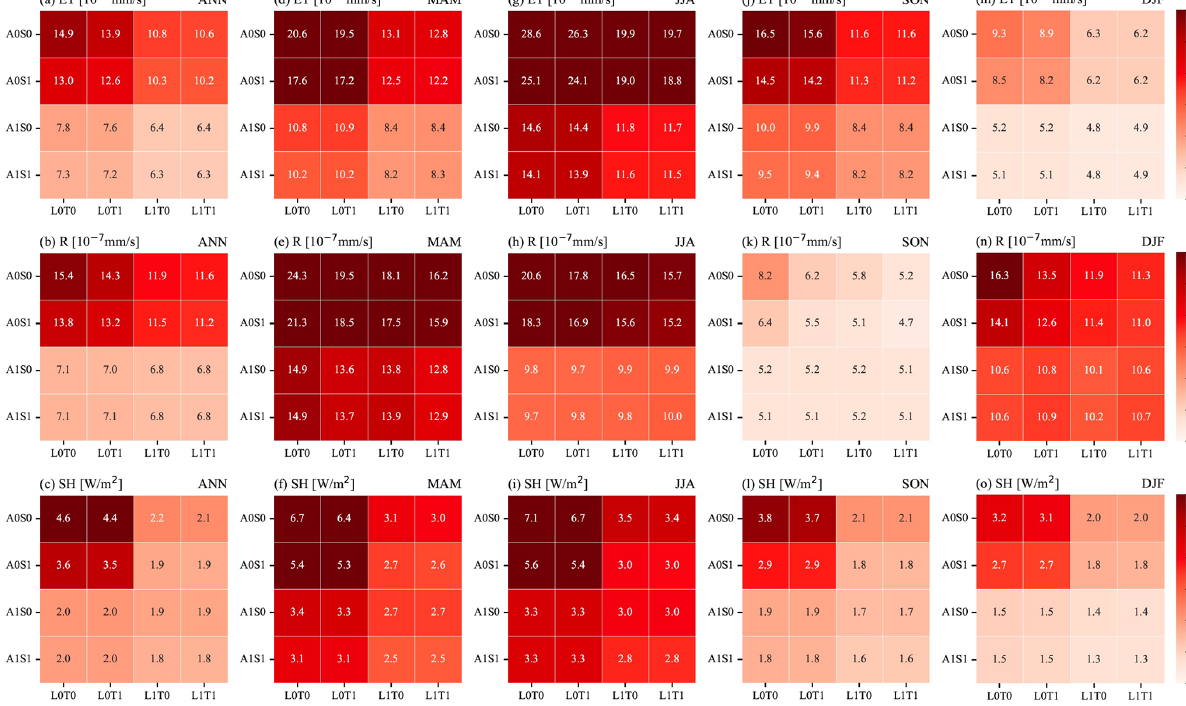
Figure 9. CONUS-averaged absolute difference of SD between 16 ELM experiments and ERA5-Land reanalysis for the annual (first column) and seasonal (second–fifth column) climatological mean of ET (a, d, g, j, m) , R (b, e, h, k, n) , and SH (c, f, i, l, o) .